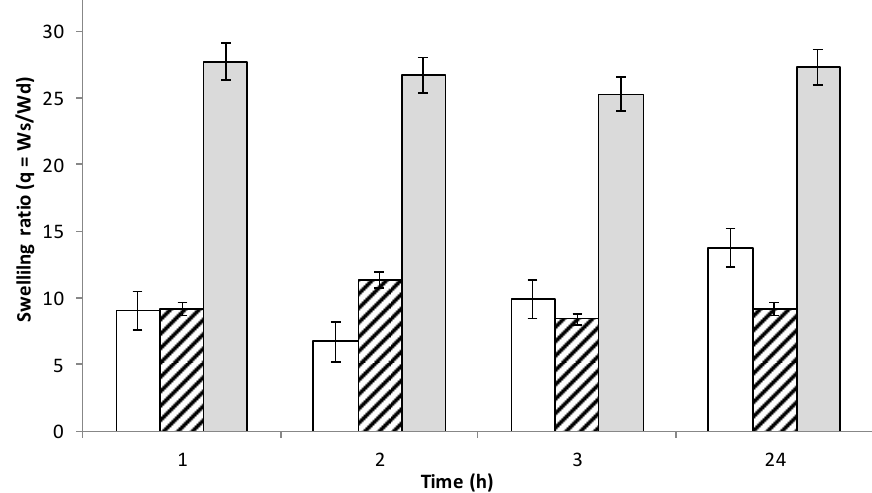
Figure 7. Water uptake studies on INVITEMA3 after UV irradiation for 30 min, 1 or 2 h up to 24 h in water.